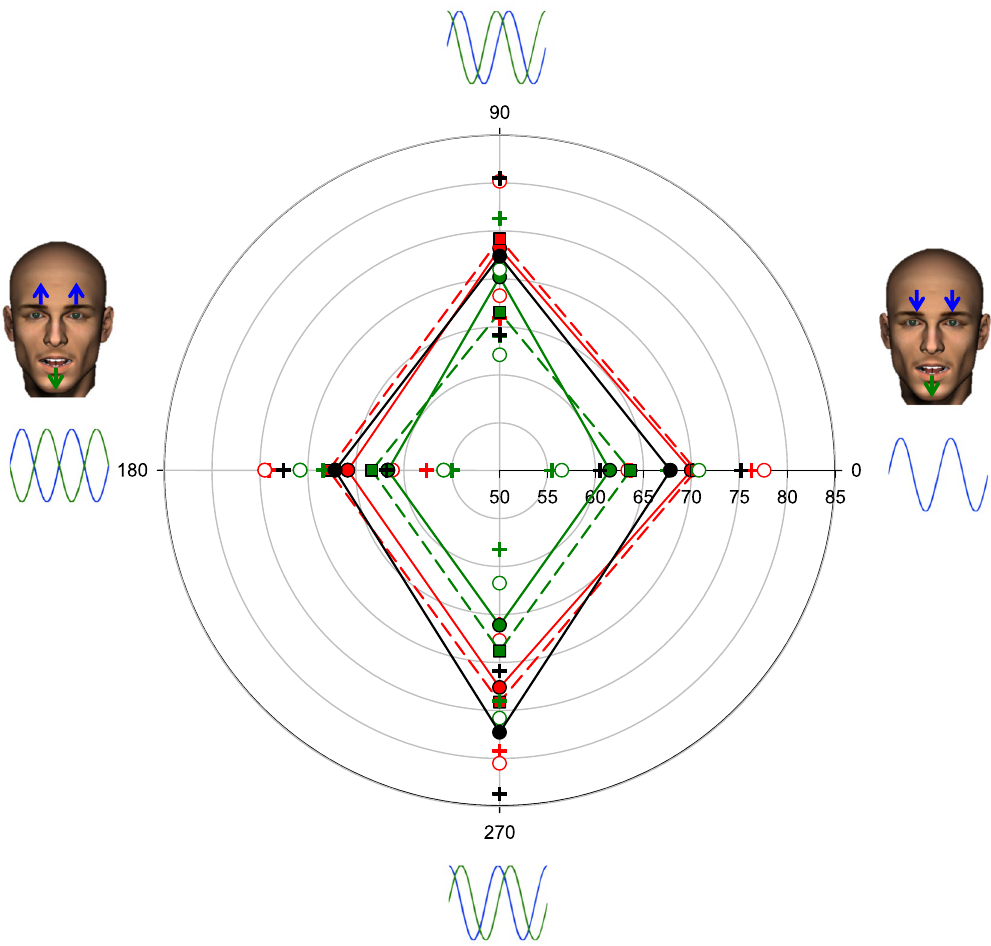
Figure 2. Percent correct for eyebrow wave detection is plotted along the radial axis (starting at 50% correct) as a function of relative phase at test. Eyebrows and mouths oscillated vertically with sinusoidal movement profiles. The diamond shape reflects the poorer detection performance for synchronous test faces as compared to asynchronous test faces ( F (3, 42) = 15.76, p < .001, η p 2 = 0.53). Adaptation to asynchronous feature motion (green) reduces discriminability of misaligned eyebrows across all test relative feature timings indicated by a main effect of adaptation type ( F (4, 56) = 6.90, p < .001, η p 2 = 0.33) and a non-significant interaction ( F (12, 168) = 0.81, p = .645, η p 2 = 0.05). Adaptation to synchronous feature motion (red) does not alter performance relative to the no adaptation control (black). Continuous red = 0°, dashed red = 180°, Continuous green = 90°, dashed green = 270° adaptation conditions. Crosses (continuous lines) and open circles (dashed lines) in matching colours show upper and lower 95% confidence limits. The stimuli were generated using Poser Pro 9 (SmithMicro; https:// www. poser softw are.